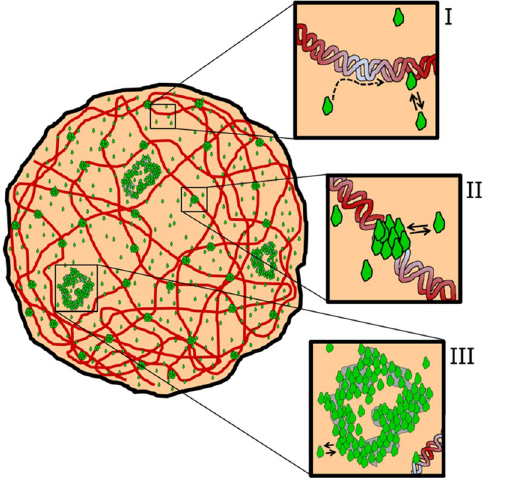
Figure 5. Model of the dynamic nuclear organization of GR. Schematic representation of GR dynamic partition within the nuclear landscape. GR diffusing molecules engage in shorter-lived and longer-lived interactions with chromatin targets (I), DNA-dependent foci (II) or NCoA-2 bodies (III). To simplify the scheme, the cartoon does not include the oligomeric state of